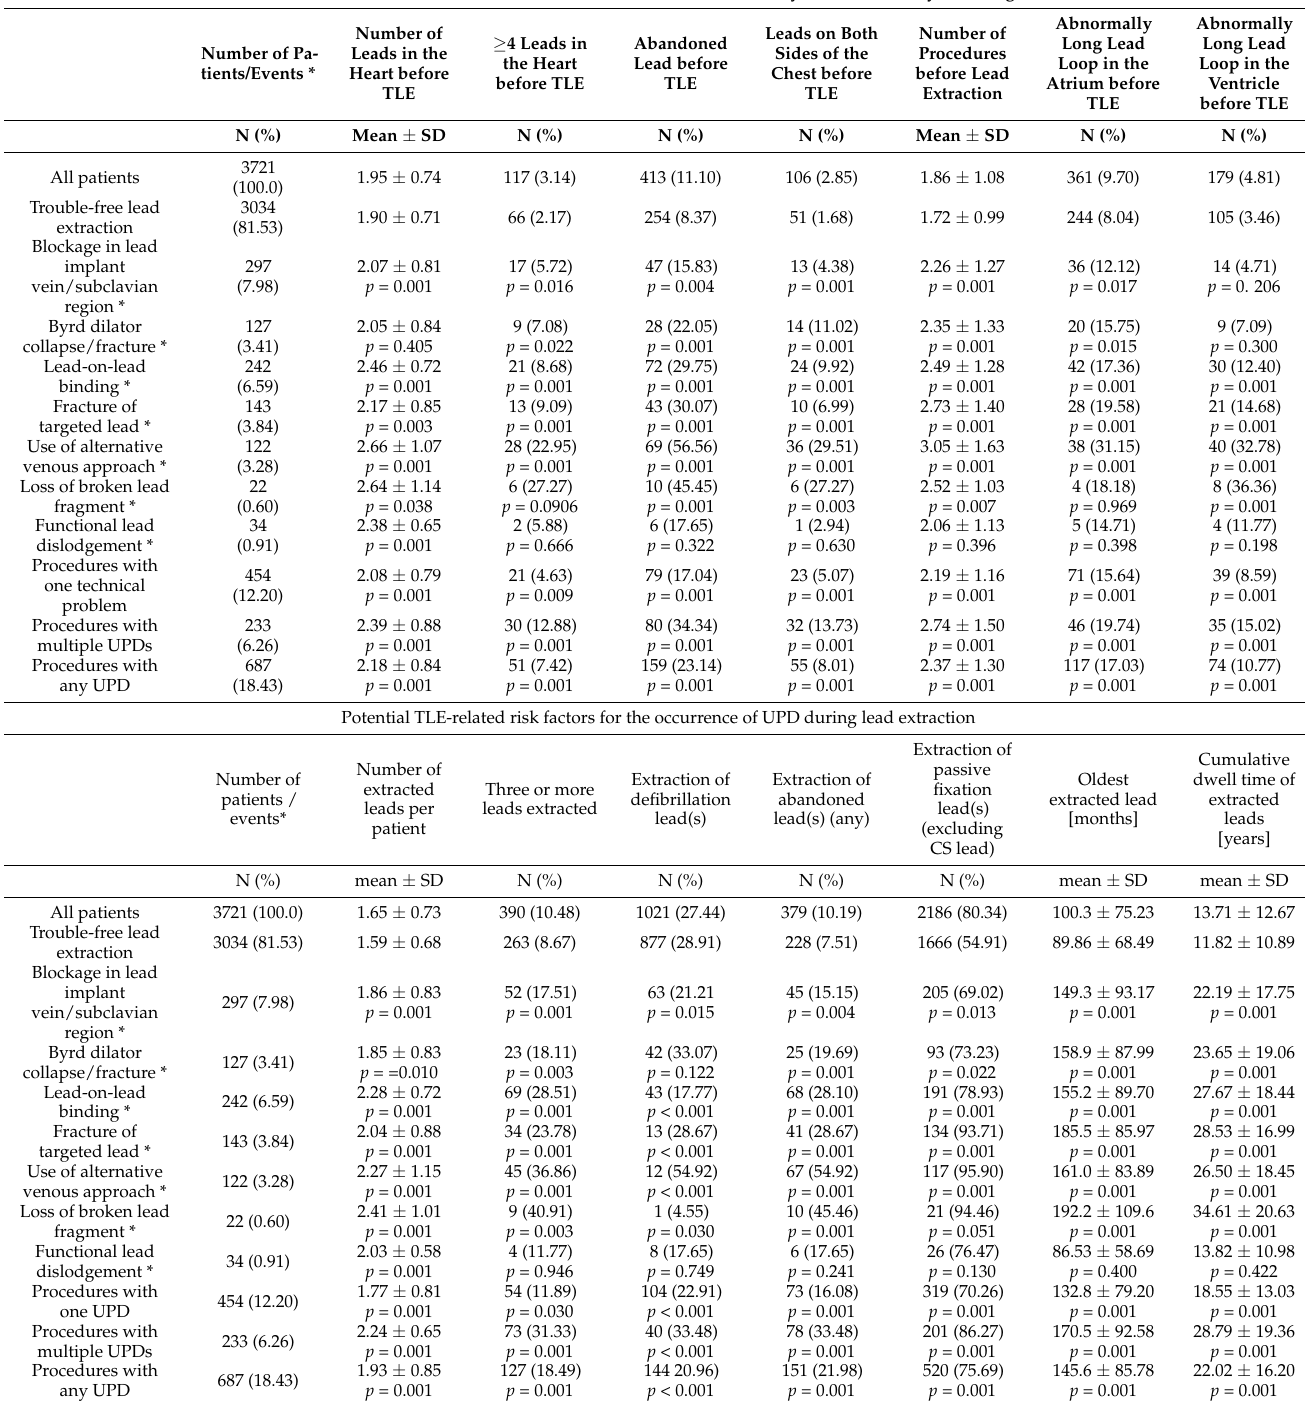
Table 3. Potential risk factors for the occurrence of unexpected procedure difficulties related to system, history of pacing, and extraction